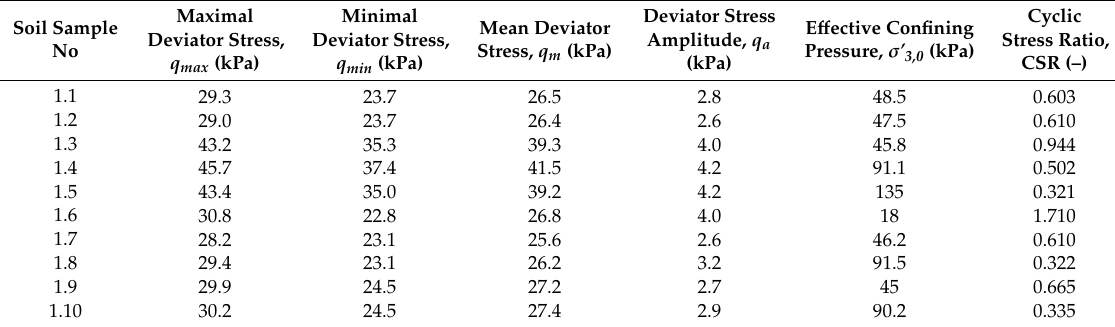
Table 2. The cyclic triaxial test loading